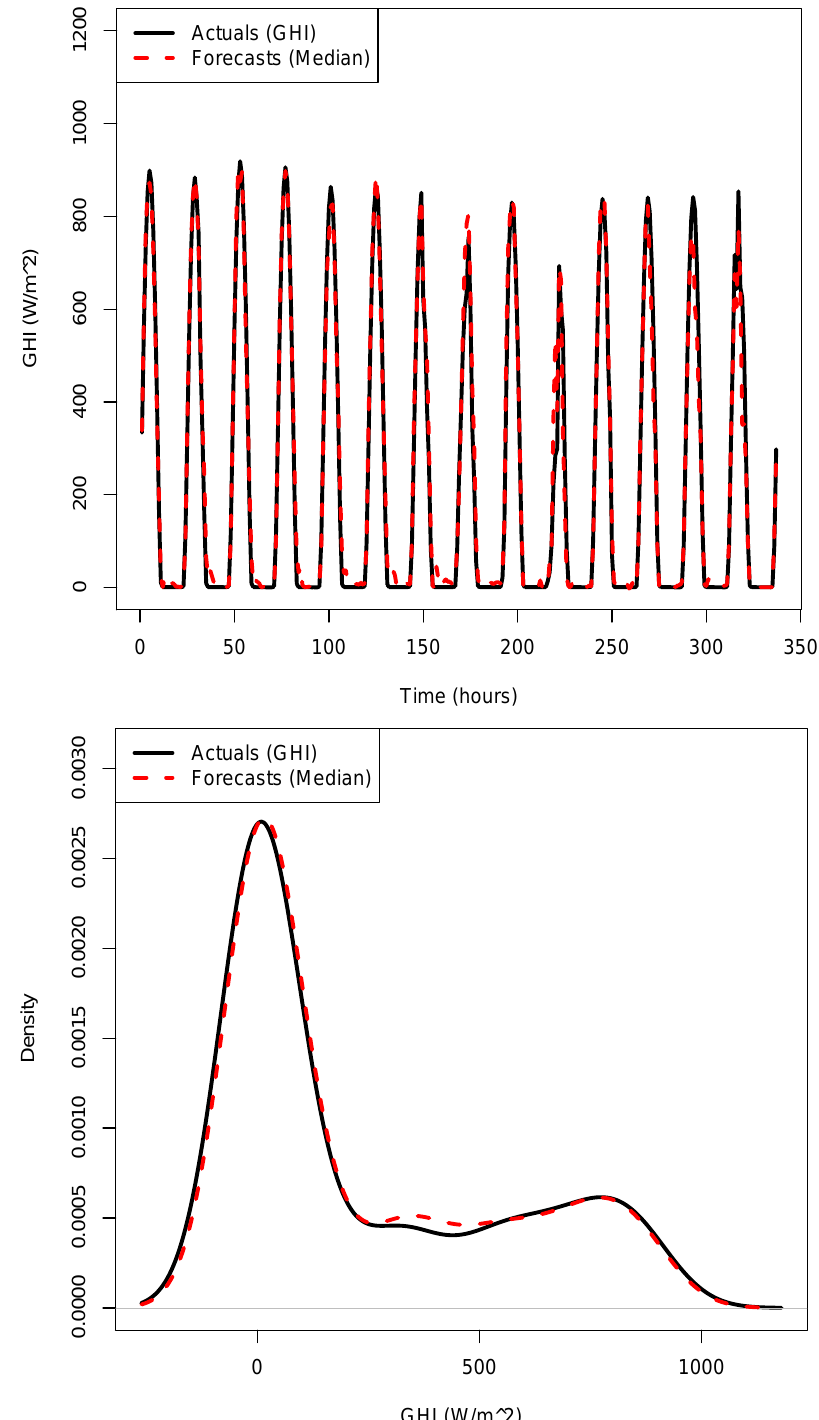
Figure A1. Top panel: Plot of actual solar irradiance superimposed with the combined median forecasts in April 2010 (337 forecasts). Bottom panel: Density plot of actual solar irradiance superimposed with the combined median